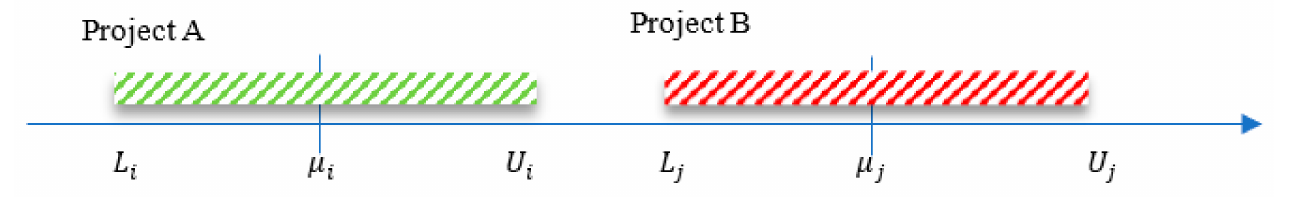
Figure 15. Possible condition one: different means and similar domain